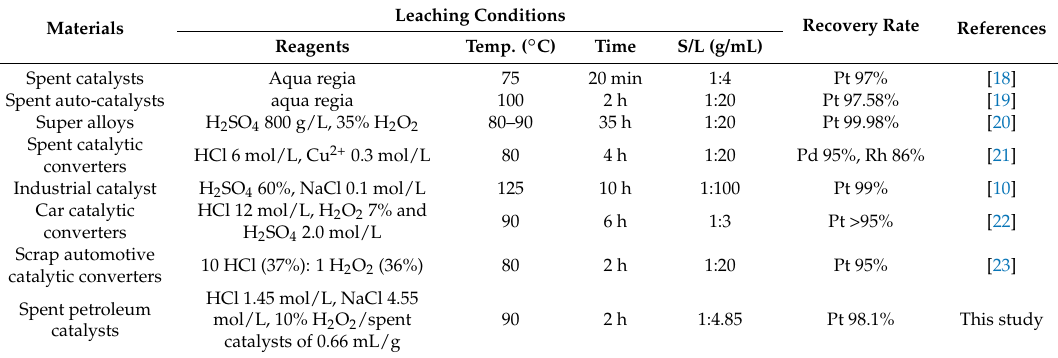
Table 1. Some typical leaching of platinum group metals (PGMs) from spent